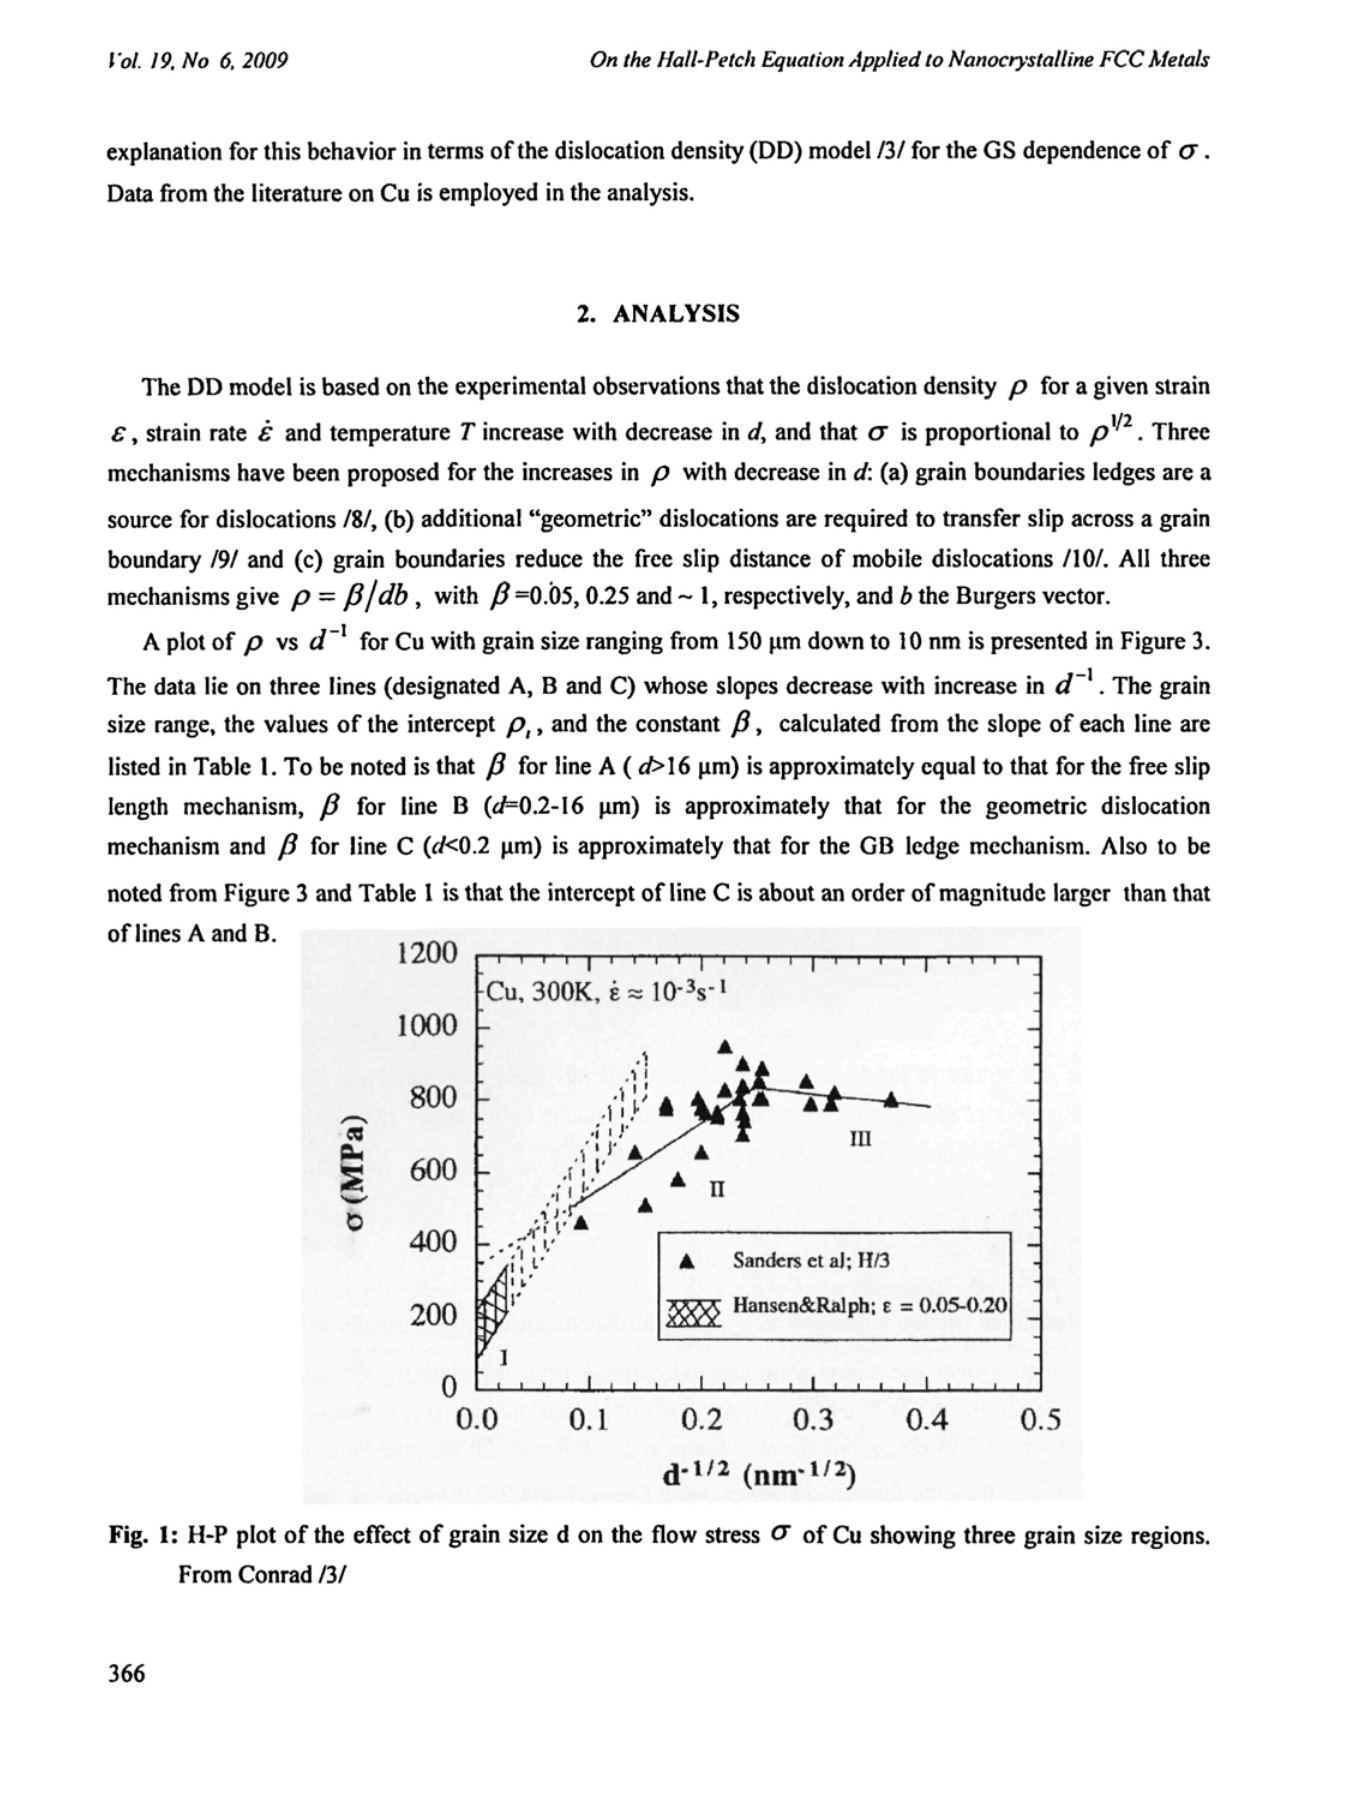
Fig. 1: H-P plot of the effect of grain size d on the flow stress cr of Cu showing three grain size regions. From Conrad /3/